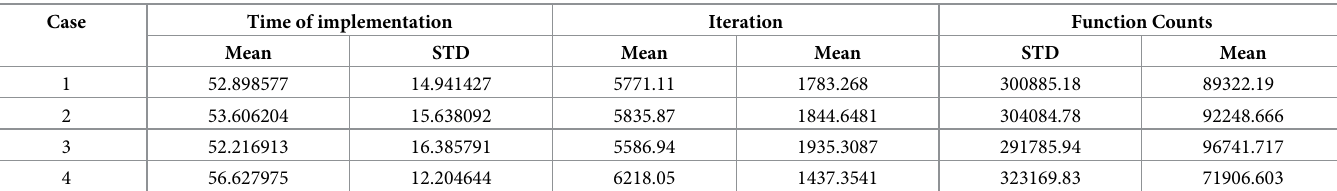
Table 8. Complexity representations for problem